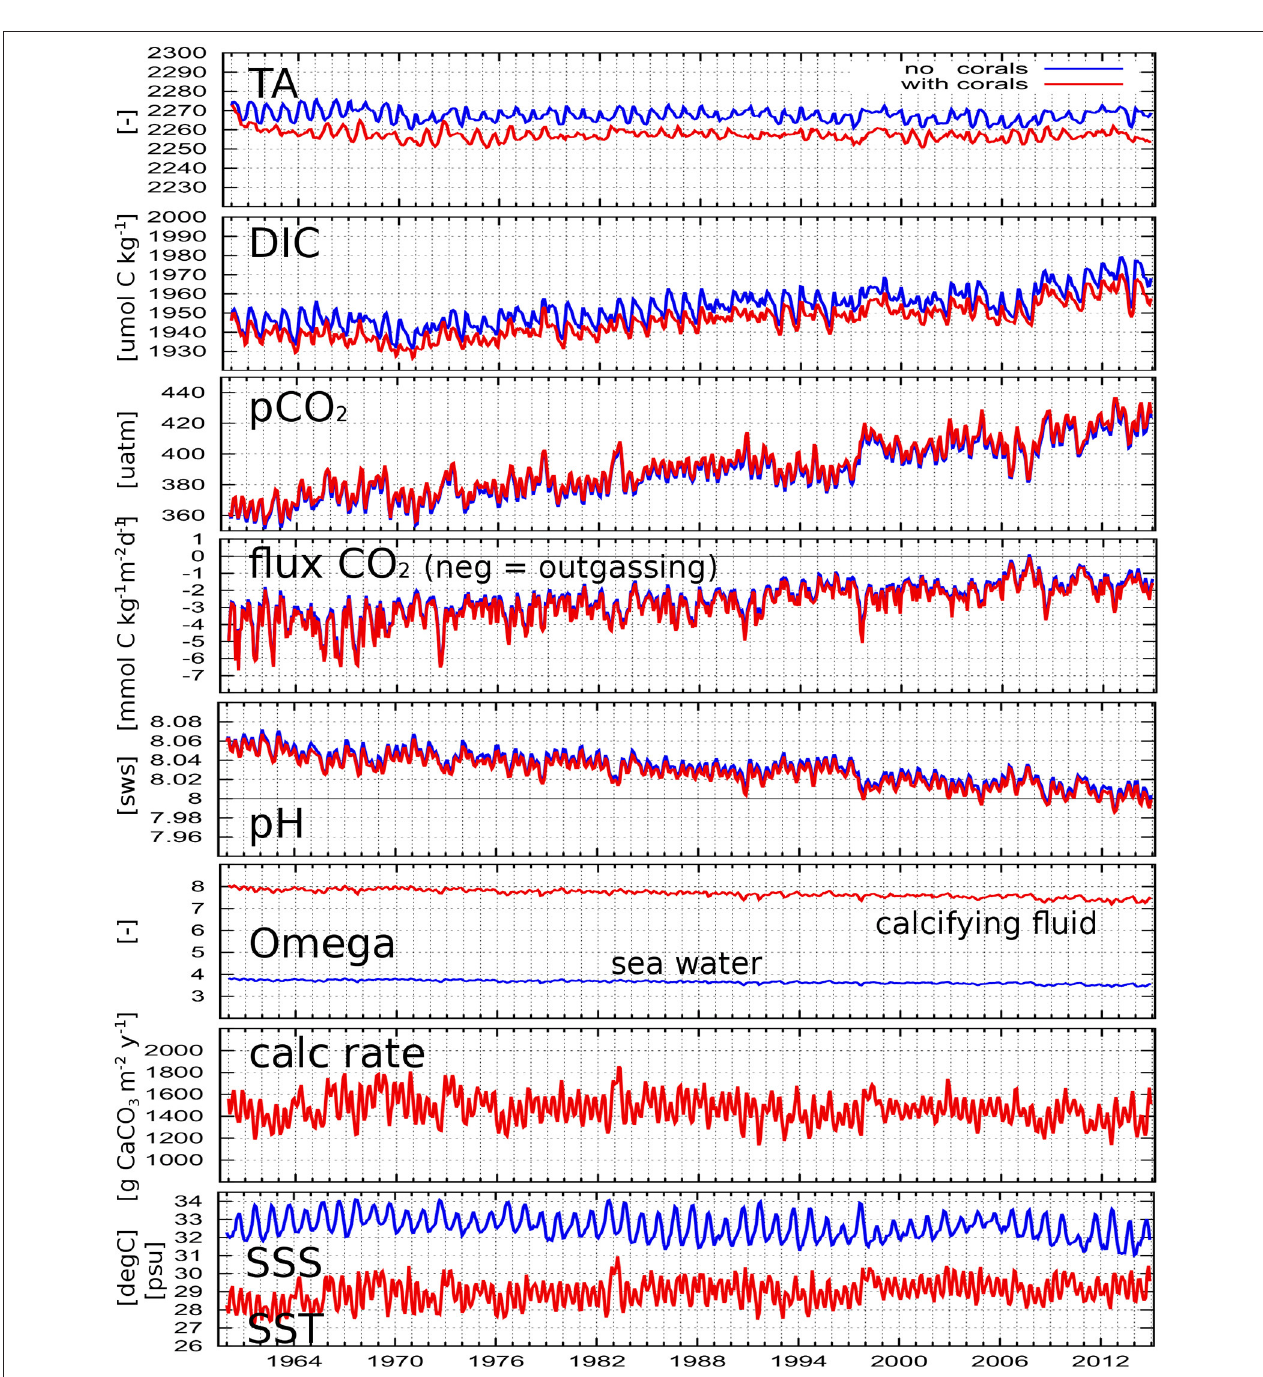
FIGURE 8 | Simulated parameters as spatially averaged monthly means for the Java Sea without biological processes (blue) and with calcification (red). pH is in seawater scale; “Omega” is the saturation state of aragonite; “calc rate” means aragonite calcification rate. SSS and SST are for both simulations.